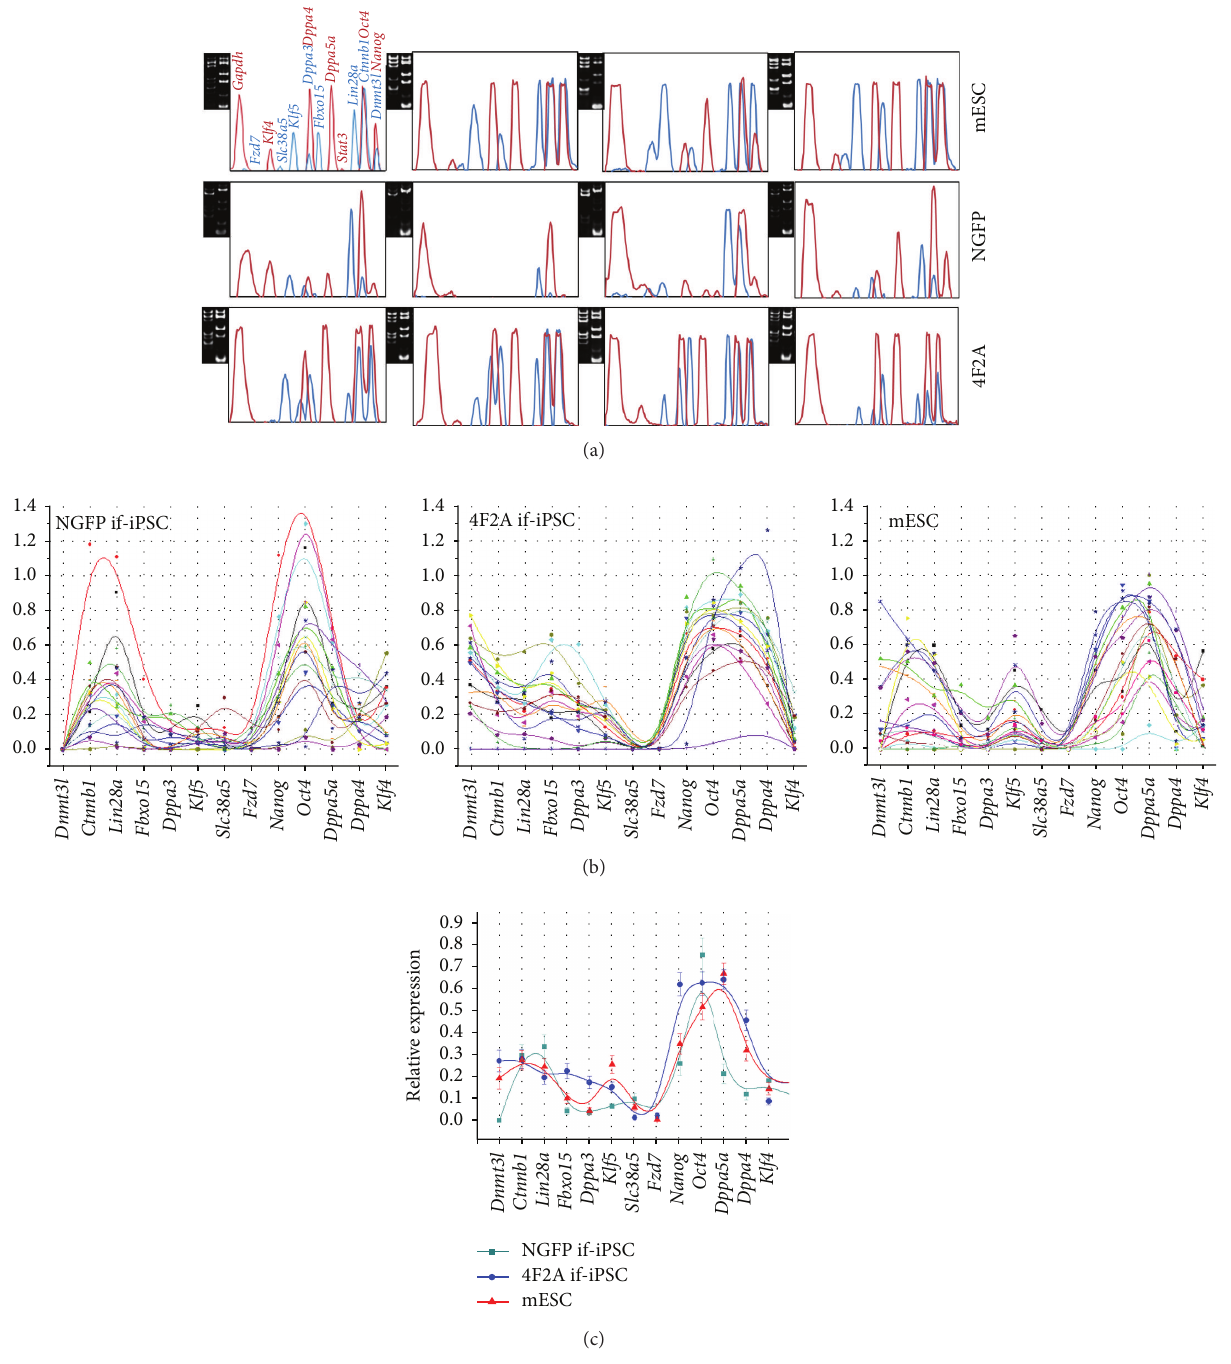
Figure 2: Expression profiles of pluripotency genes in single if-iPSC colonies from NGFP, 4F2A, and mESC groups. (a) Representative gene expression density profiles of single if-iPSC colonies in the mESC, NGFP if-iPSC, and 4F2A if-iPSC groups. Each panel represents a density profile of a single colony (4 profiles per each group) and the corresponding gel image is shown left with lanes of individual gene groups (Figure 1(e)). AxioVision intensity profile tool (v4.8) was used for peak profiles. (b) Gene expression profiles (GEPs) of individual colonies. Spline-type plots are shown where individual lines in different colors denote the expression profiles of the pluripotency genes in individual colonies. (c) Mean GEPs of individual iPSC colony groups. The Gapdh level is set as the normalization standard. Slc38a5 is included as a control that was previously shown to be more expressed in if-iPSCs than in stabilized iPSC and ESCs [23]. Error bars, standard